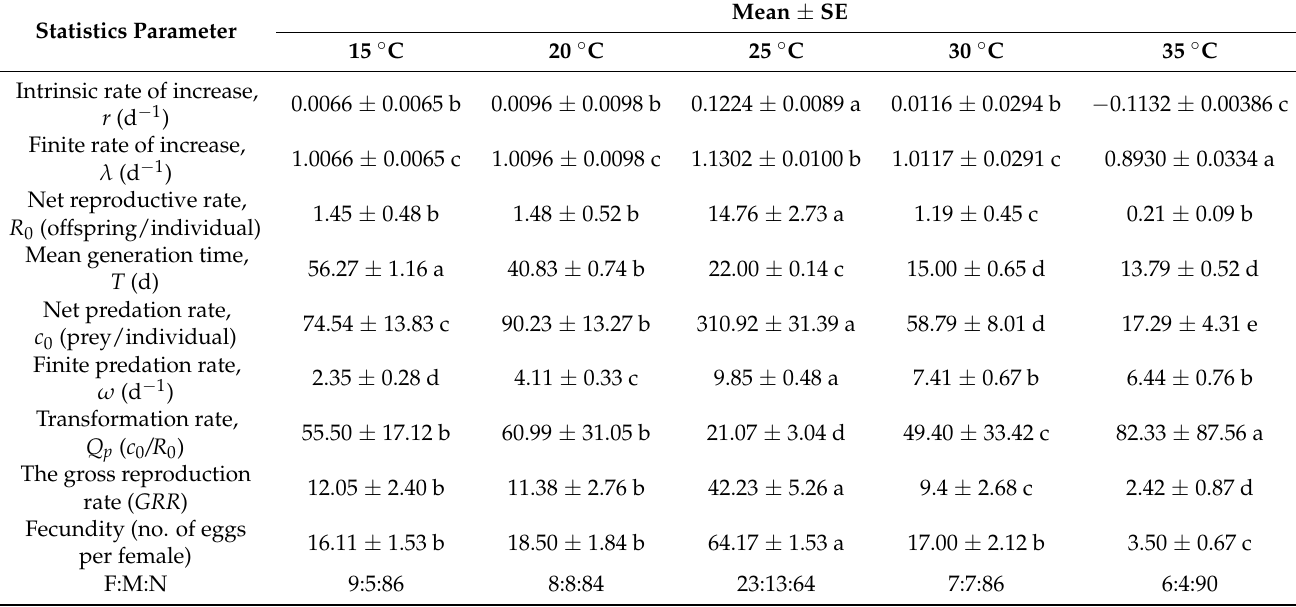
Table 2. Population statistics parameters (mean ± SE) of O. minutus starting from 100 eggs feeding on D. minowai at different